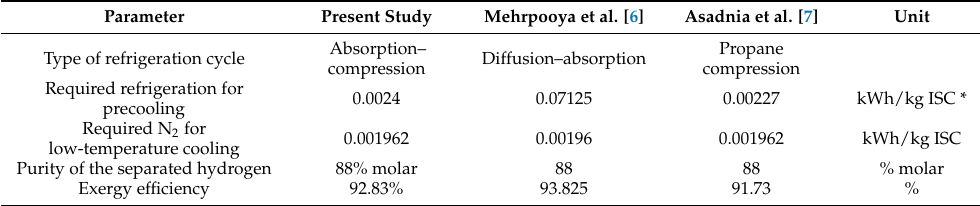
Table A1. Validation of the main parameters of the cryogenic hydrogen purification